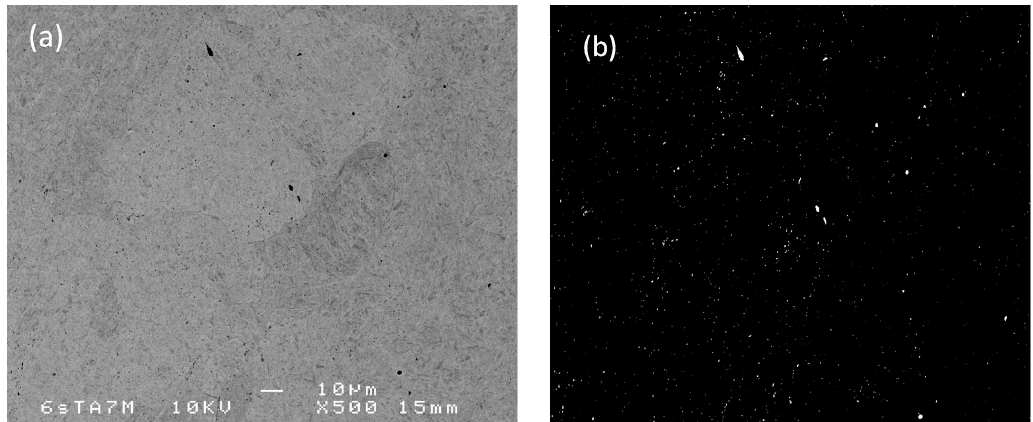
Figure 8. Original SEM image of Sample 1 ( a ) and the same image after binarization with the same scale for image analysis ( b ).